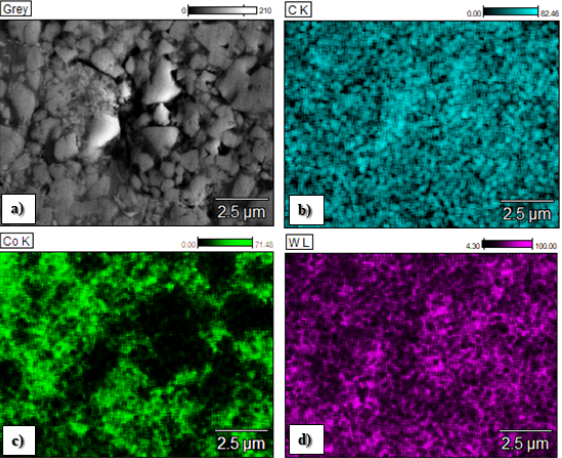
Figure 6. Elemental distribution maps of spraying elements in the analyzed area of the C2 coating obtained during thermal spraying: ( a )—central part of the layer, ( b )—map of the carbon, ( c )—map of the cobalt, ( d )—map of the tungsten.